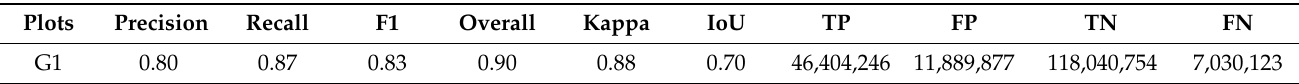
Table 2. Validation of the U-net algorithm identification